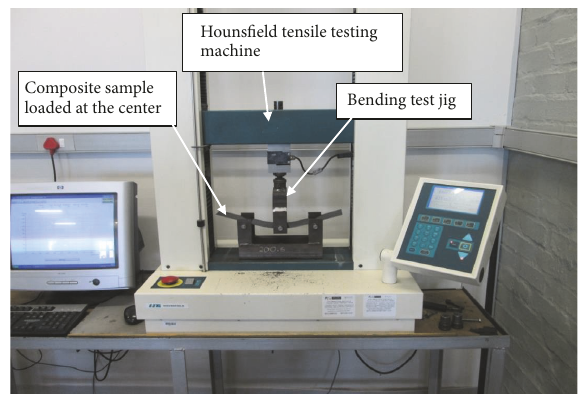
Figure 2: Three-point bending